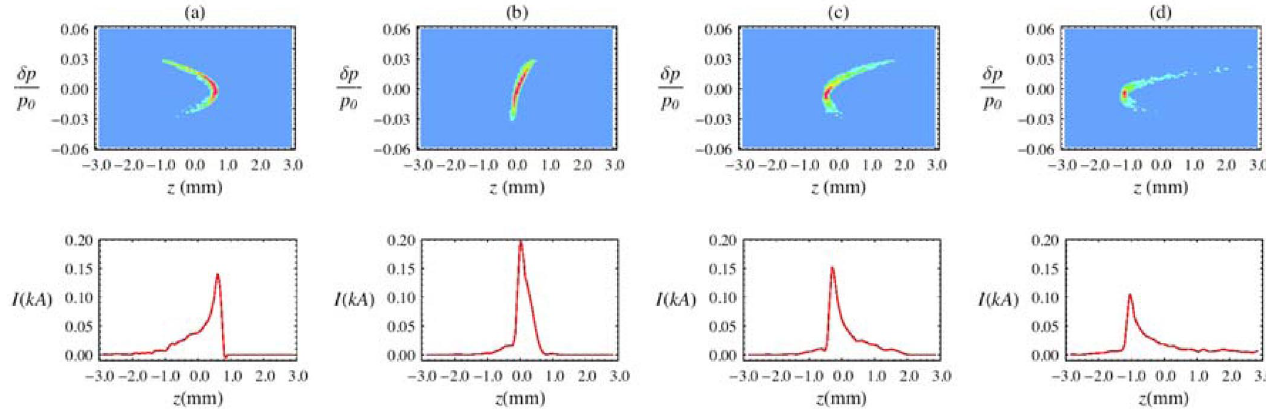
FIG. 7. (Color) The longitudinal phase space plots and density profiles obtained from the ELEGANT results corresponding to the sextupole values (cid:30) (cid:1) 0 , 1094, 1641, and 2735 m (cid:12) 3 , respectively, from the plot in Fig. 6, illustrating the progression of the phase space values are (cid:12) 2 : 11 , 0.02, 1.08, and 3.22 m, respectively. compression and decompression. The corresponding simulated T 566